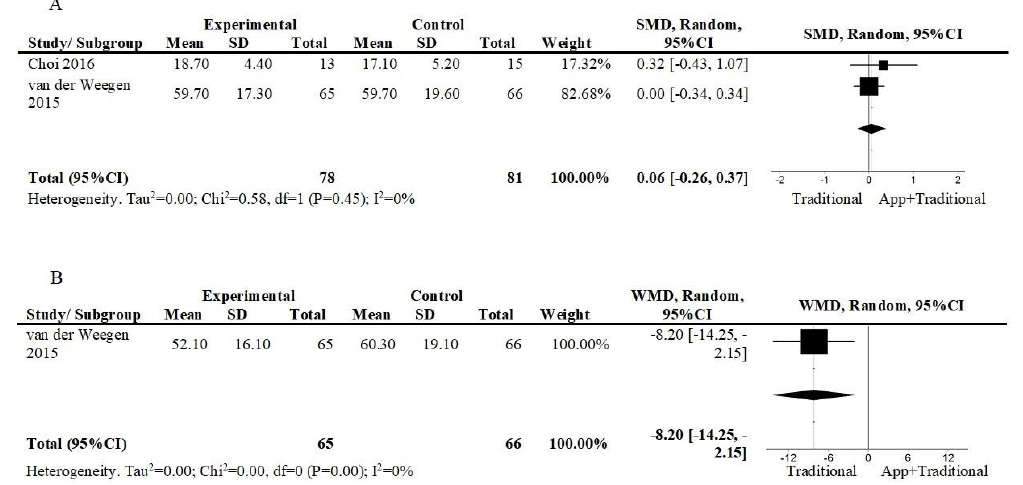
Figure 7. Forest plot of comparison, outcome: self-reported self-efficacy in exercise/physical activity: A) App+Traditional vs. Traditional, short term. Abbreviations: CI, confidence interval; df, degrees of freedom; SMD, standardized mean difference; B) App+Traditional vs. Traditional, follow-up. Abbreviations: CI, confidence interval; df, degrees of freedom; WMD, weighted mean difference.